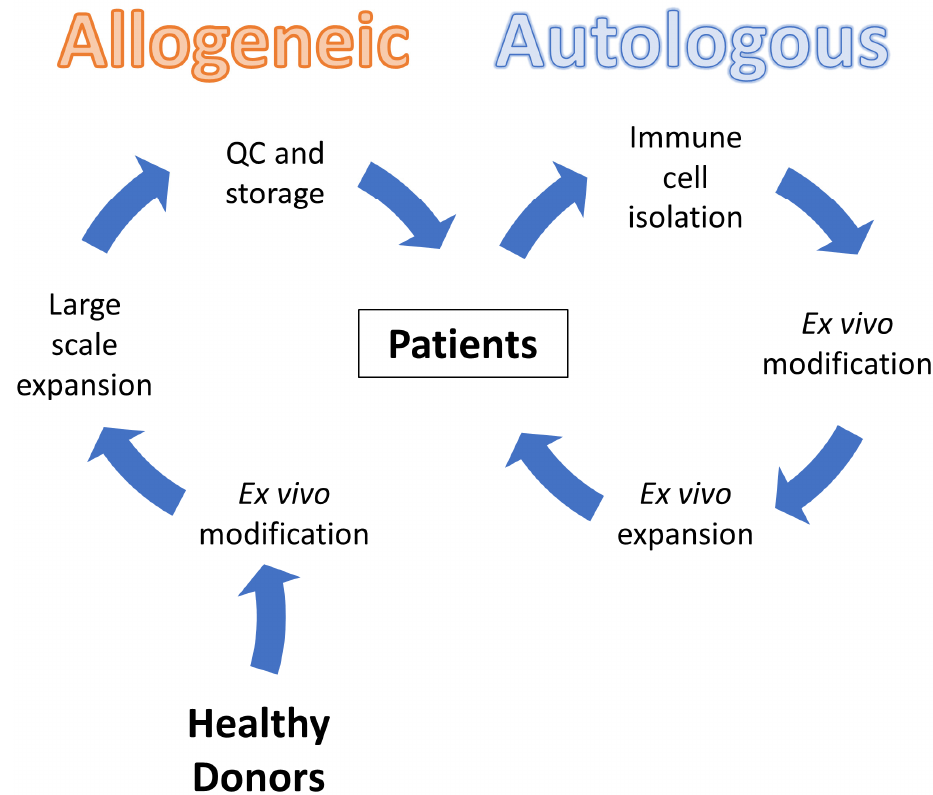
Figure 1. Allogeneic and autologous adoptive transfer of CAR-based immune cells.